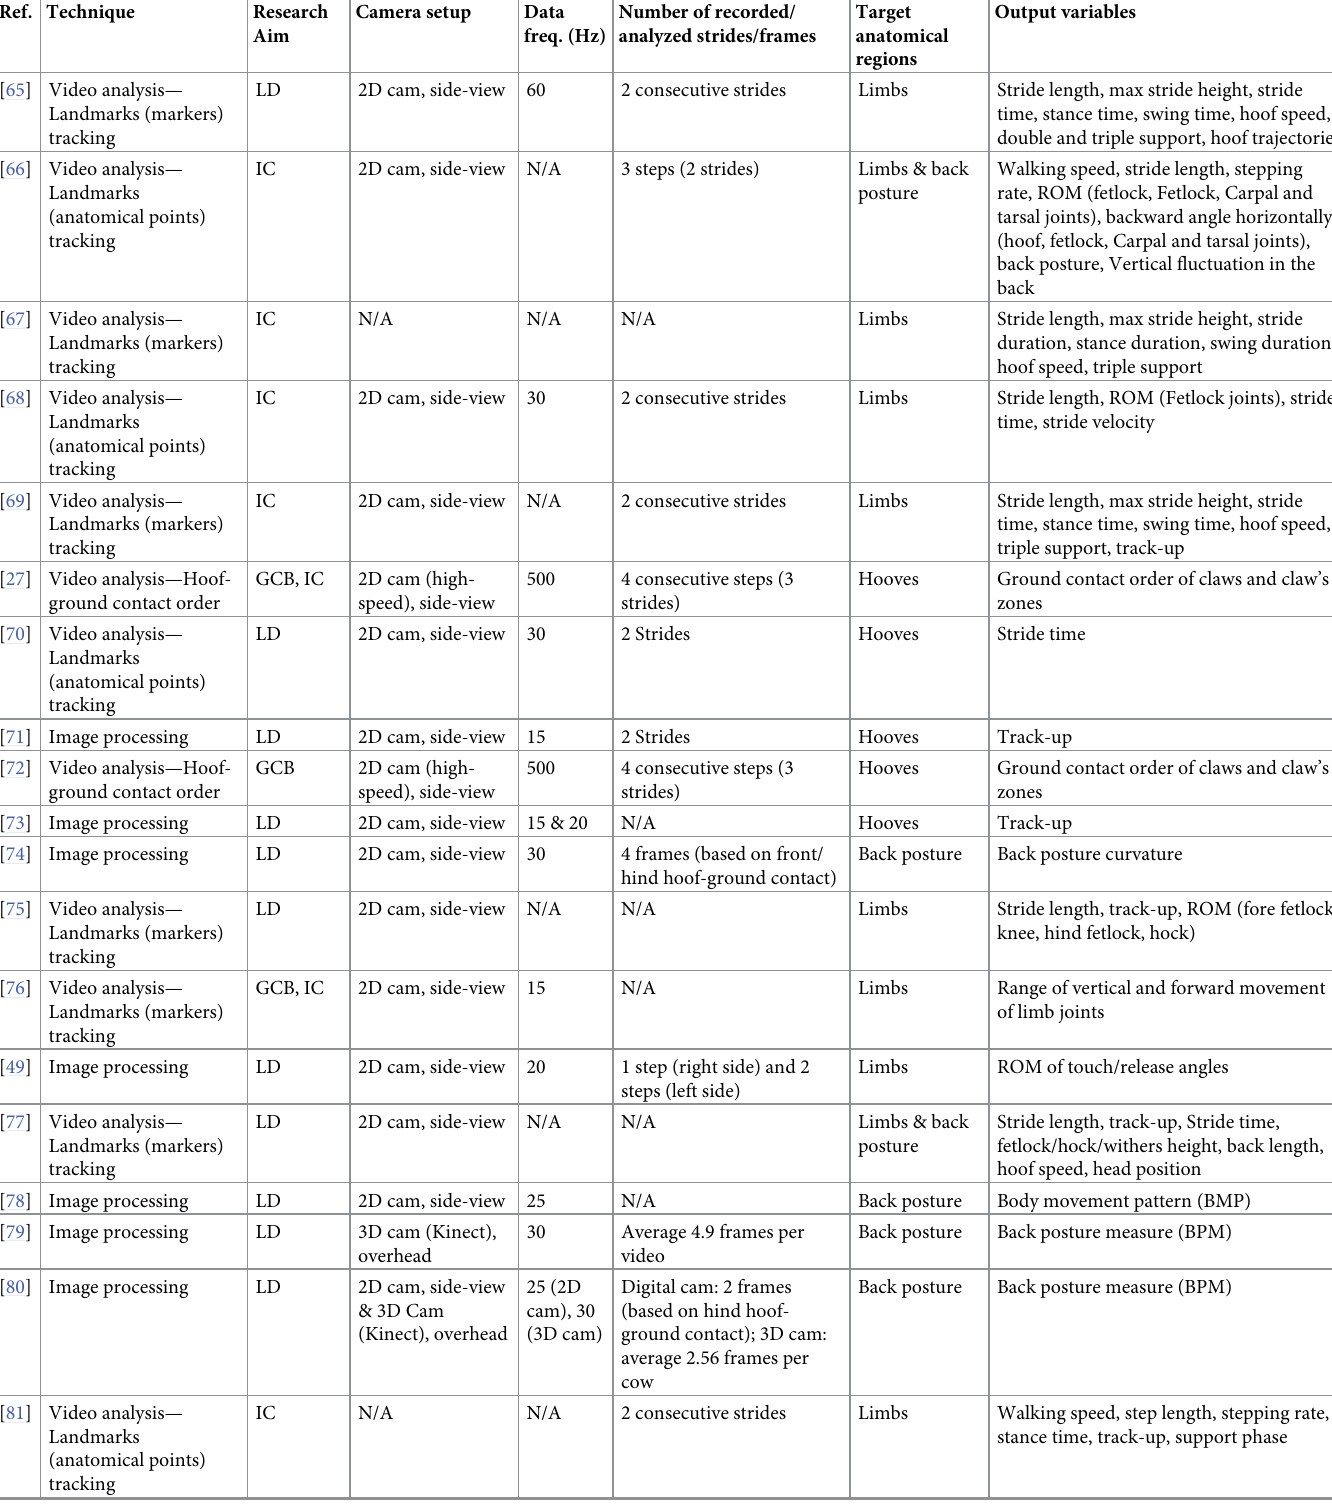
Table 5. Overview of studies included in the review that used vision-based technologies (VB). Ref.